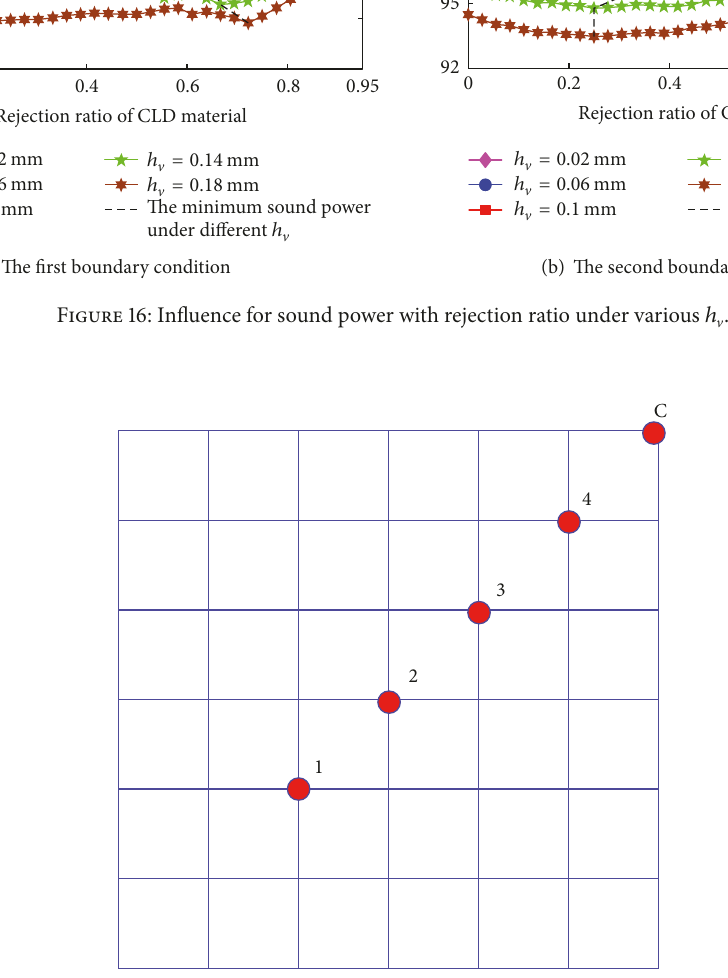
Figure 17: Locations of exciting force shown at finite element partition of 1/4